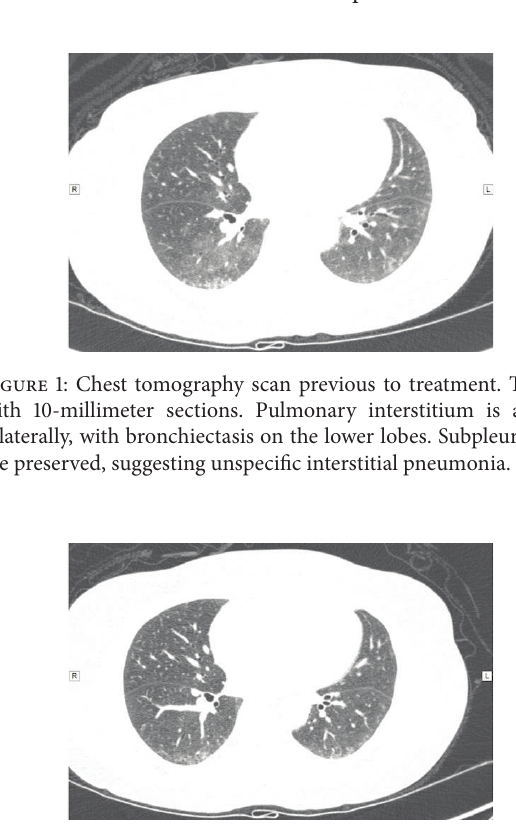
Figure 2: Chest tomography scan after two weeks of treatment. Images on same level and resolution. Note the improvement on the ground-glass pattern on lower